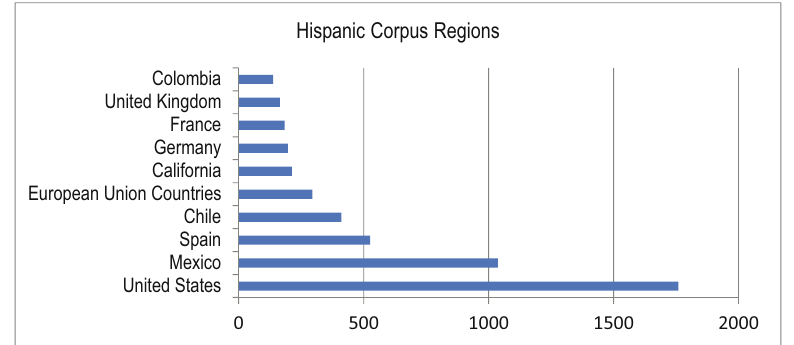
Figure 3: Most mentioned geographic areas in the Hispanic